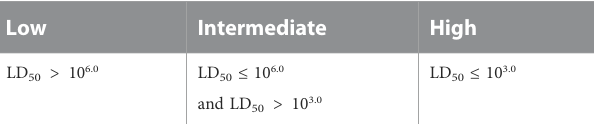
TABLE 1 Summary statistics of data collected.